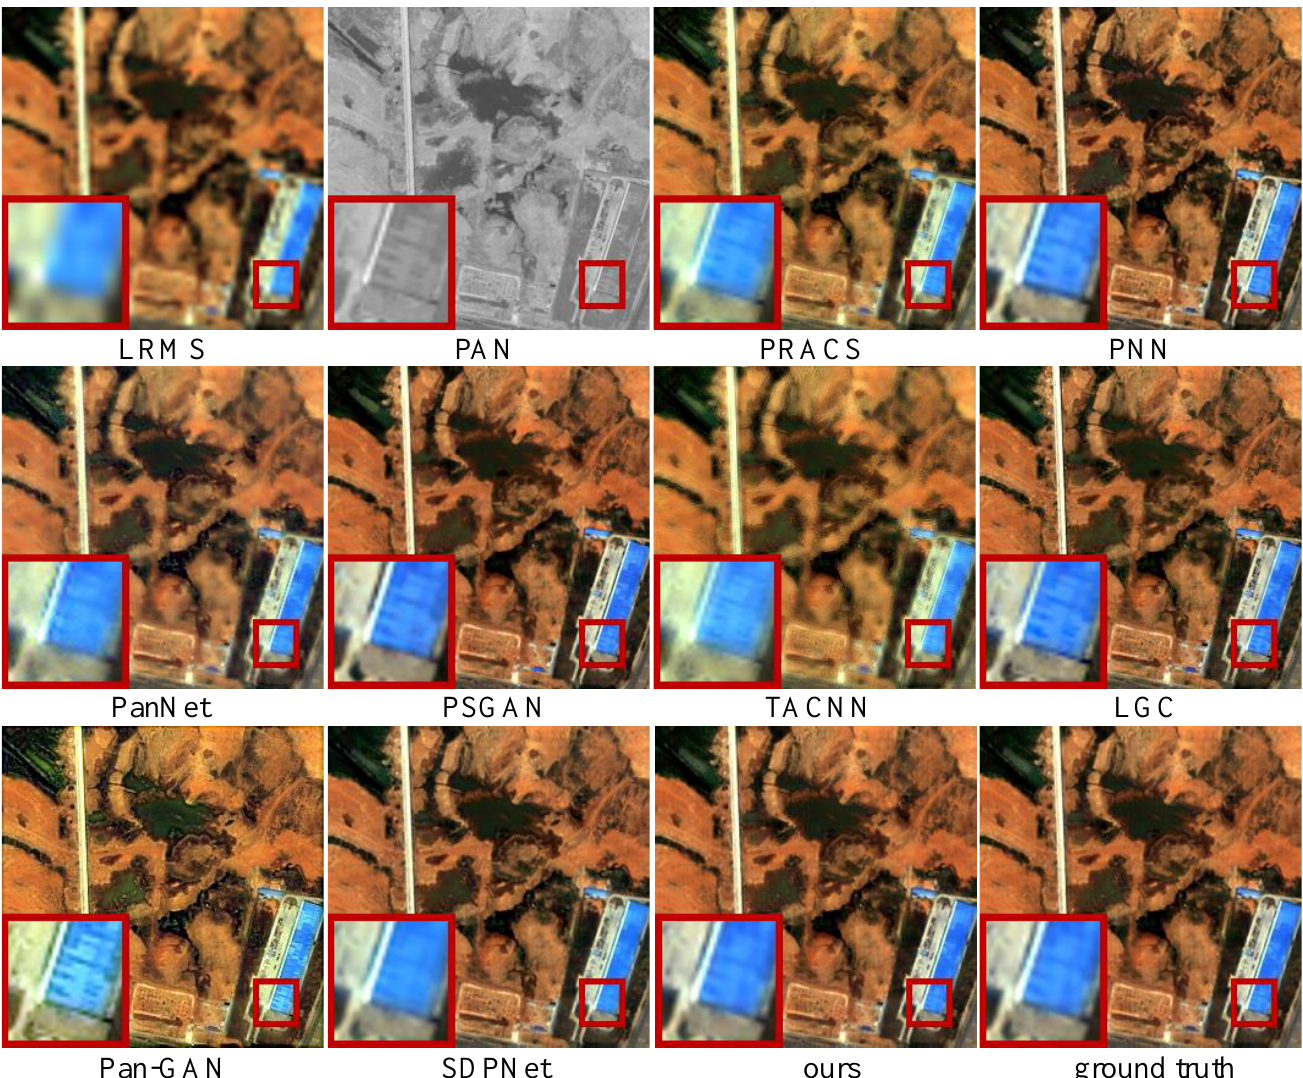
Figure 5. Qualitative comparison of CPNet with other eight pan-sharpening methods on the data from the QuickBird data